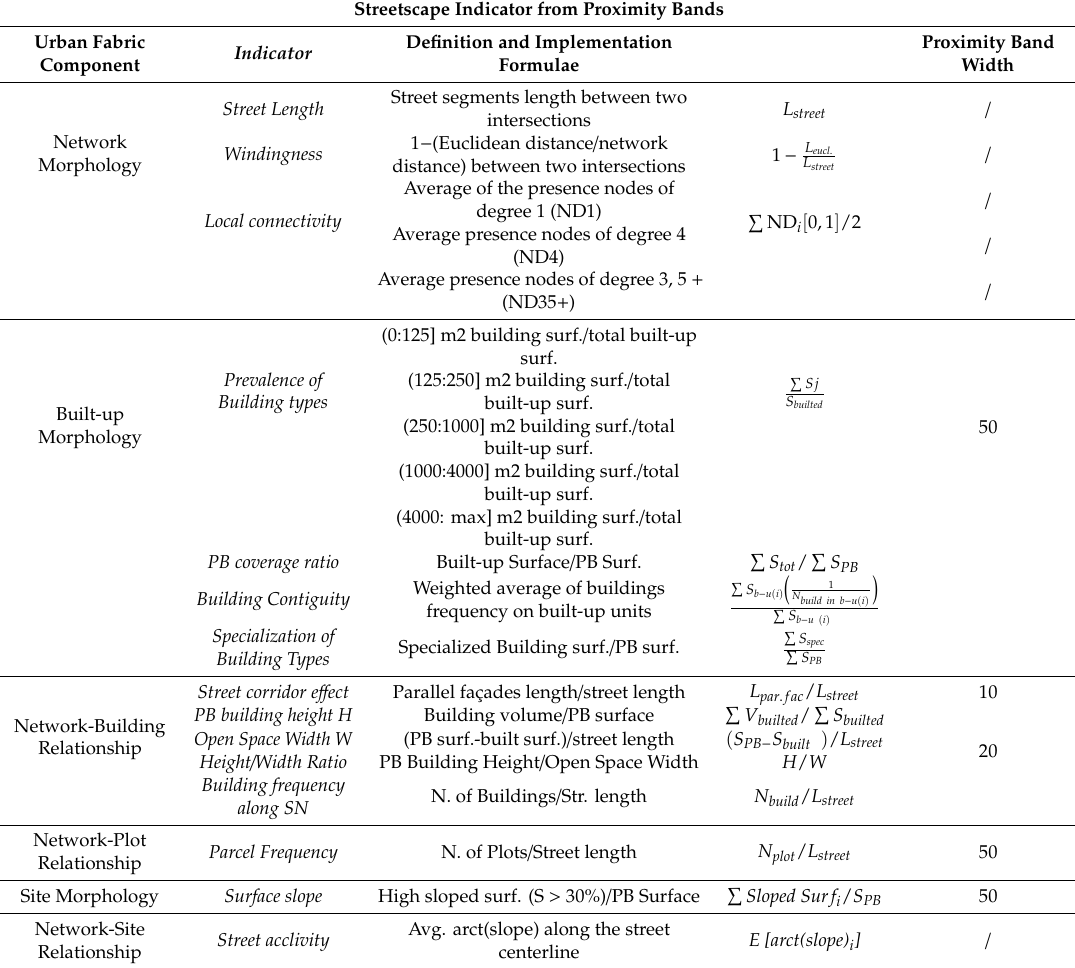
Table A5. Streetscape indicators implemented through the proximity band procedure (source: